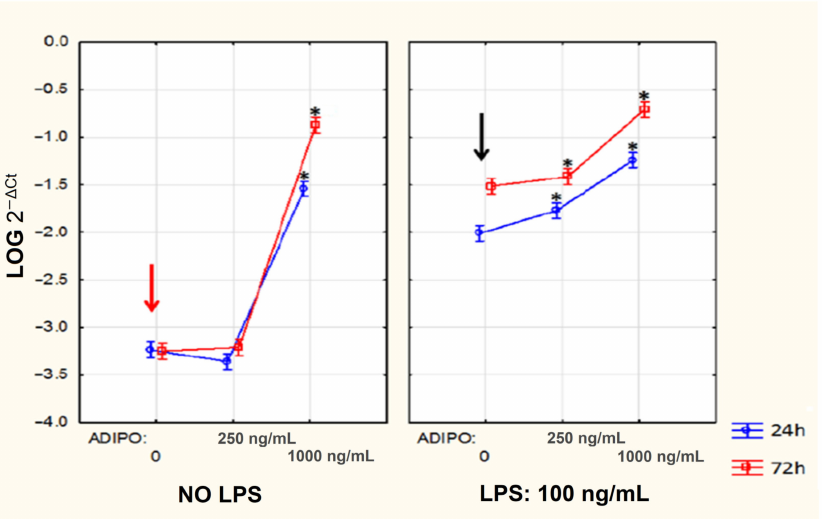
Figure 7. The effect of adiponectin (ADIPO) stimulation of human fibroblast-like synoviocytes (HFLSs) on IL-6 mRNA expression. Red arrow indicates negative control (without adiponectin and without LPS). Black arrow indicates control with LPS alone (without adiponectin). Means from 3 experiments ± 95% confidence intervals are presented. * p < 0.05 (Tukey post hoc test in comparison to cells not stimulated with